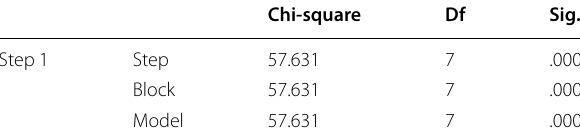
Table 3 Overall Omnibus tests of model coefficients Table 4 Overall model summary